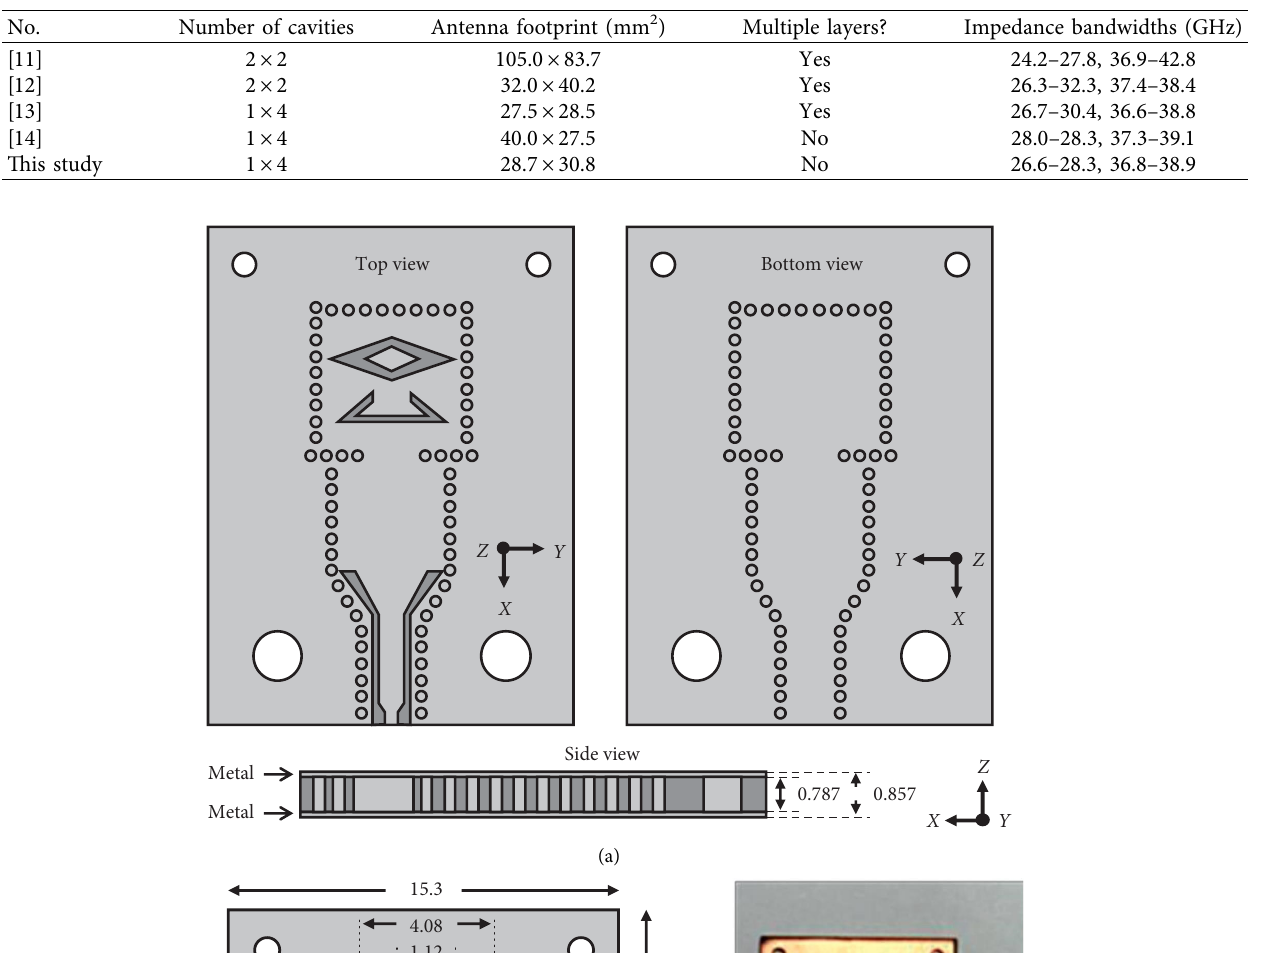
Table 1: Comparison of dual-band SIW antenna arrays (28/38GHz).